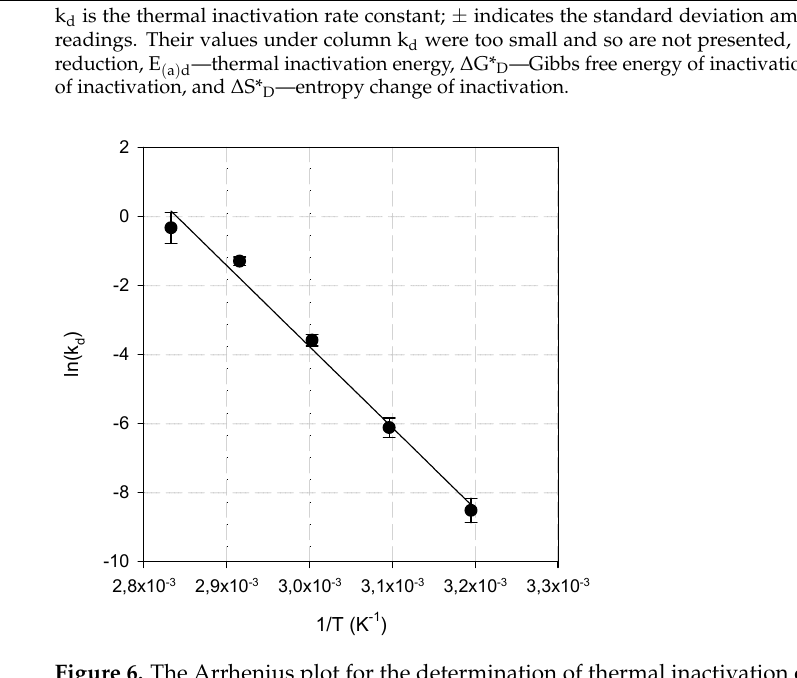
Figure 6. The Arrhenius plot for the determination of thermal inactivation energy.